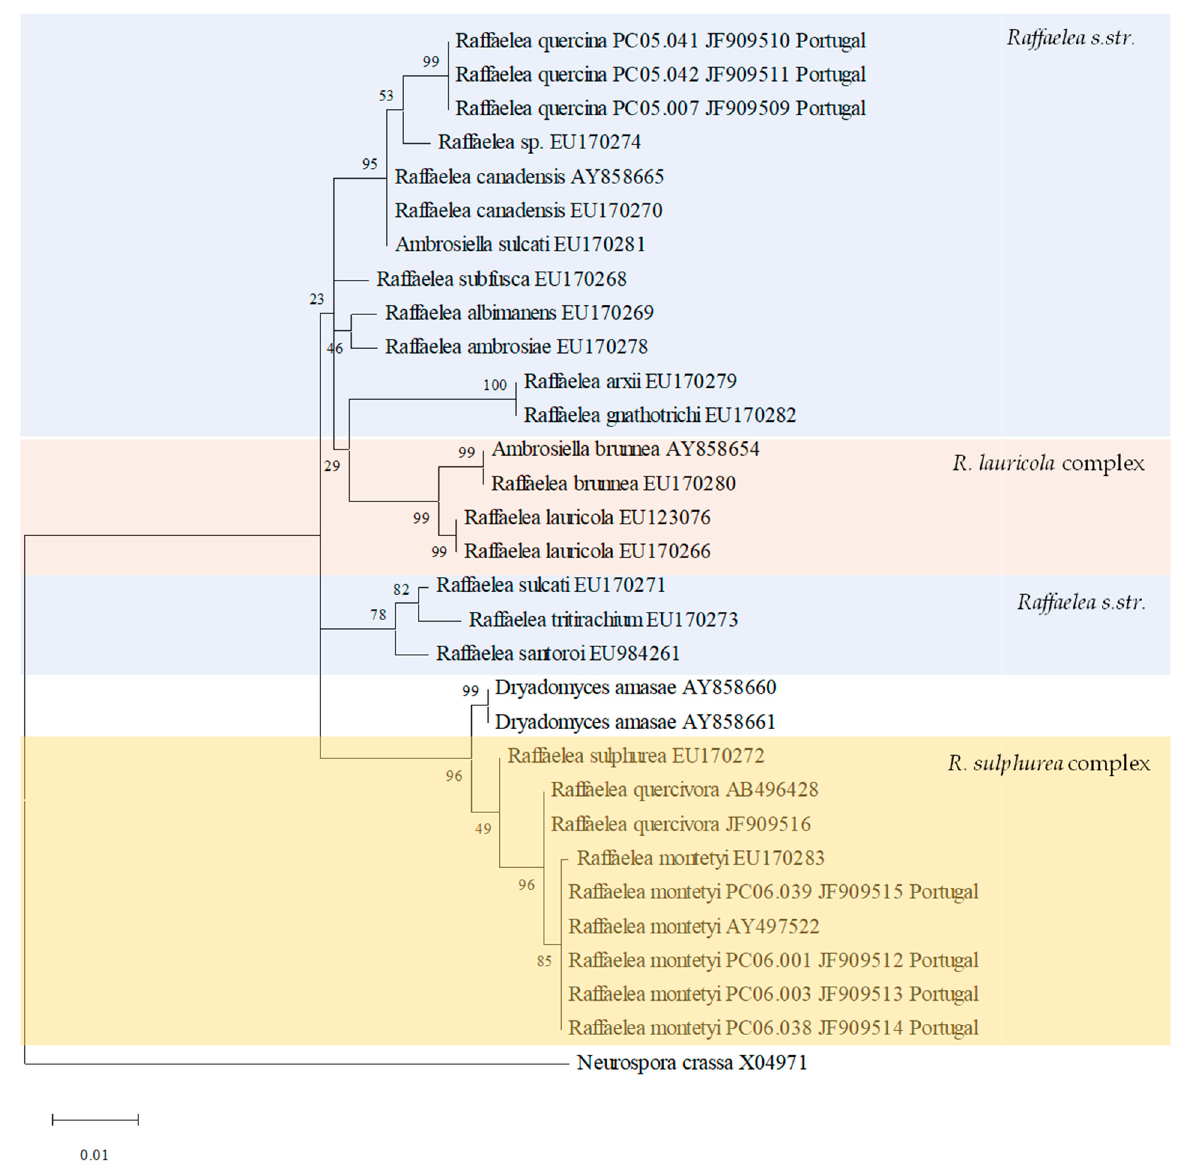
Figure 3. Phylogenetic relationships of Raffaelea isolates collected from Platypus cylindrus emerged from cork oak logs based on the sequence alignment of the partial sequence (1.028 bp) of the SSU region or the rDNA. The phylogram was generated by ML analyses with 1.000 bootstrap replications. Bootstrap values are indicated at the nodes. The analysis involved 31 nucleotide sequences. There were a total of 1.022 positions in the final dataset. Evolutionary analyses were conducted in MEGA X [37].